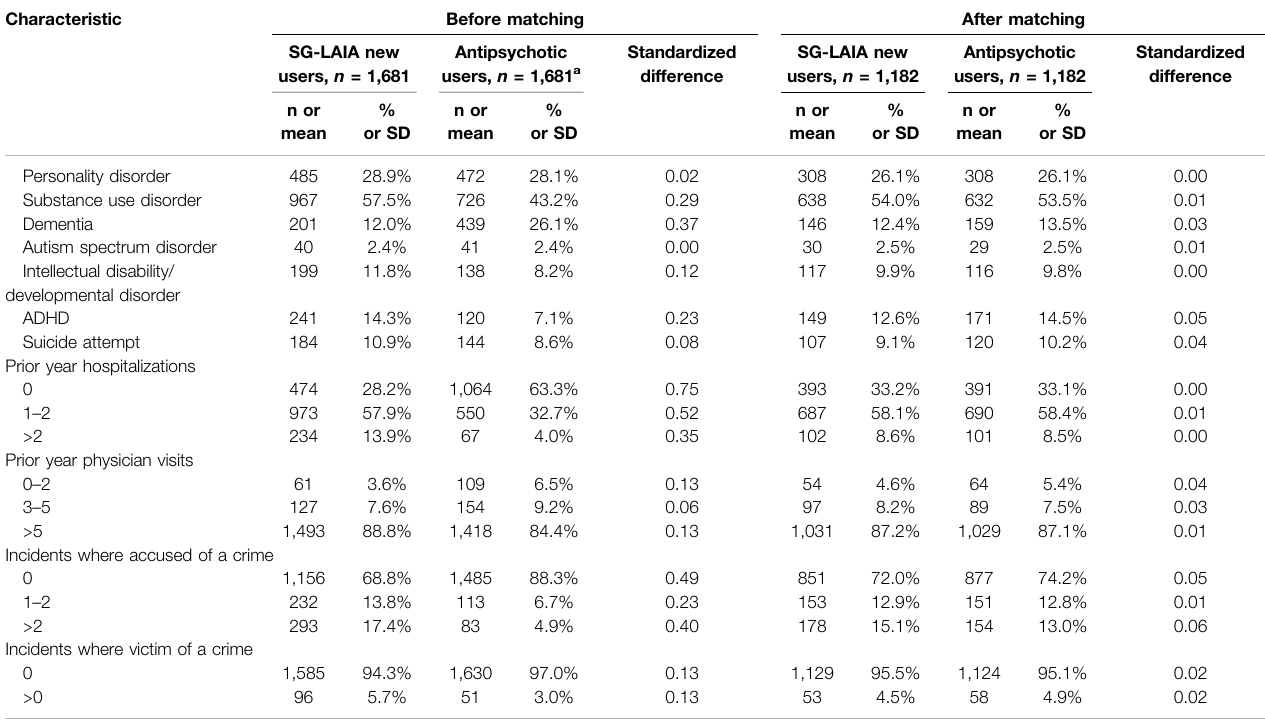
Number of Person years Crude incidence Crude hazard ratio Adjusted hazard ratio a events rate per (95% CI) (95% 100 person years